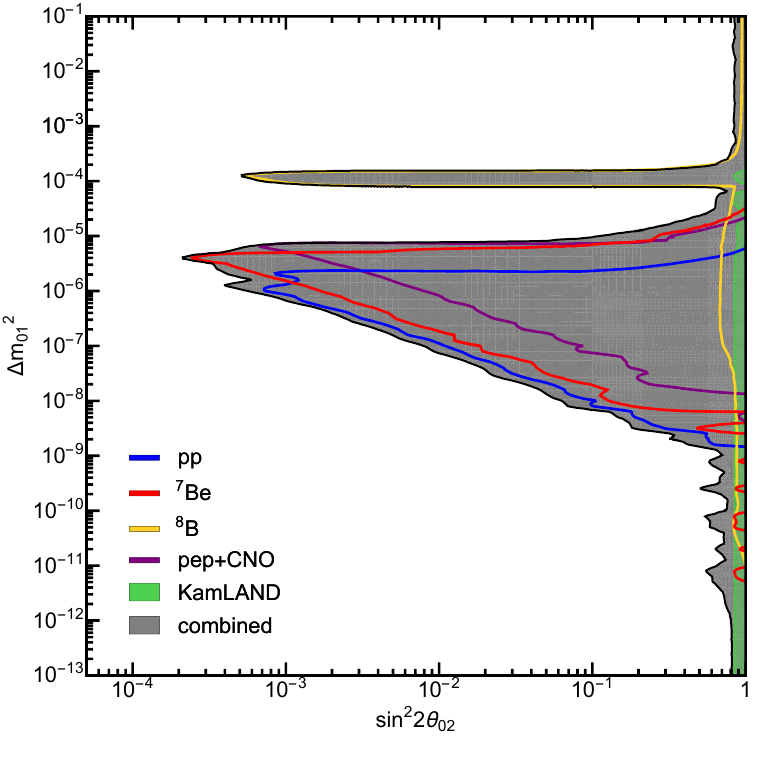
Figure 9 . Same as in figure 8, except for θ 02